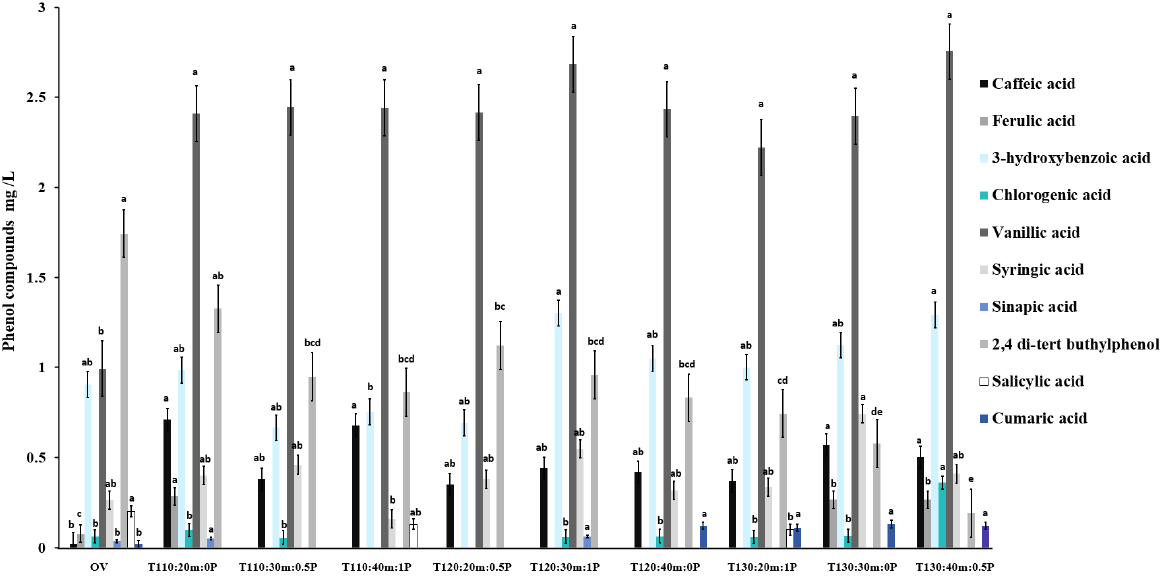
Figure 4. Phenolic compounds were identified in the original vinasses (OV) and after the treatments. Different lower letters between columns are not significantly different for each compound.